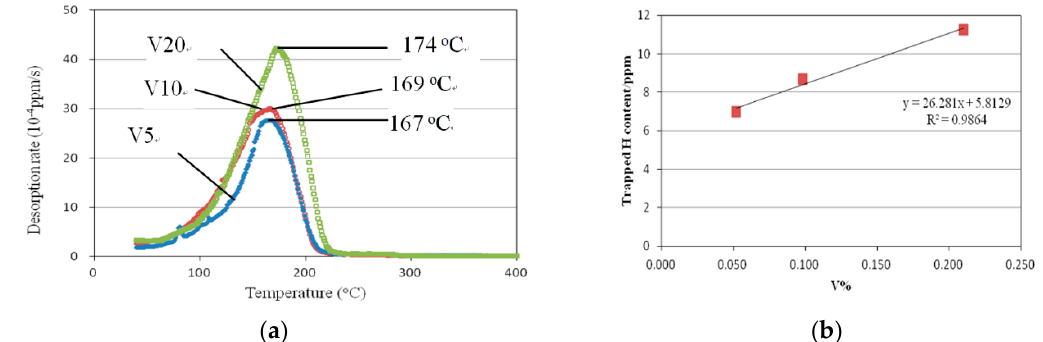
Figure 5. ( a ) Thermal hydrogen desorption rate curves of vanadium-added steels, ( b ) Total desorption hydrogen content vs vanadium content.